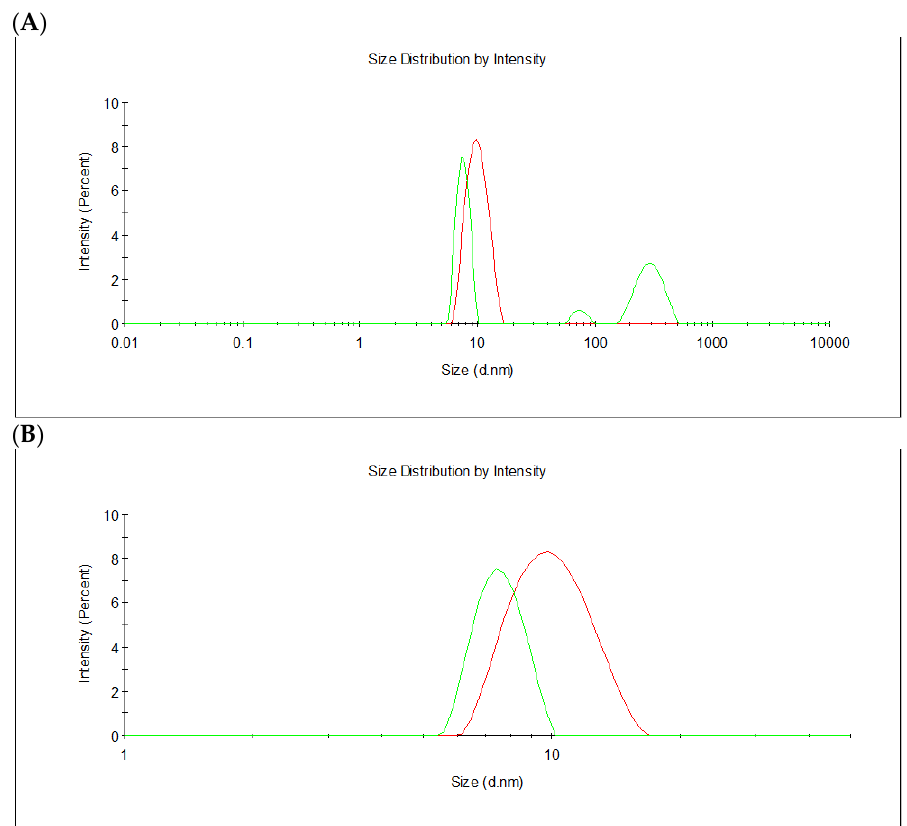
Figure 3. Size distribution by intensity for TrxFTL (red line) and FTL cleaved from TrxFTL (green line). ( A ) Size scale 0.01 – 10,000 nm diameter; ( B ) size scale 1 – 50 nm diameter. Estimated diameter for TrxFTL (9.4 nm) is higher than that estimated for cFTL (7.3 nm). Each curve represents the average of 10 independent measurements.